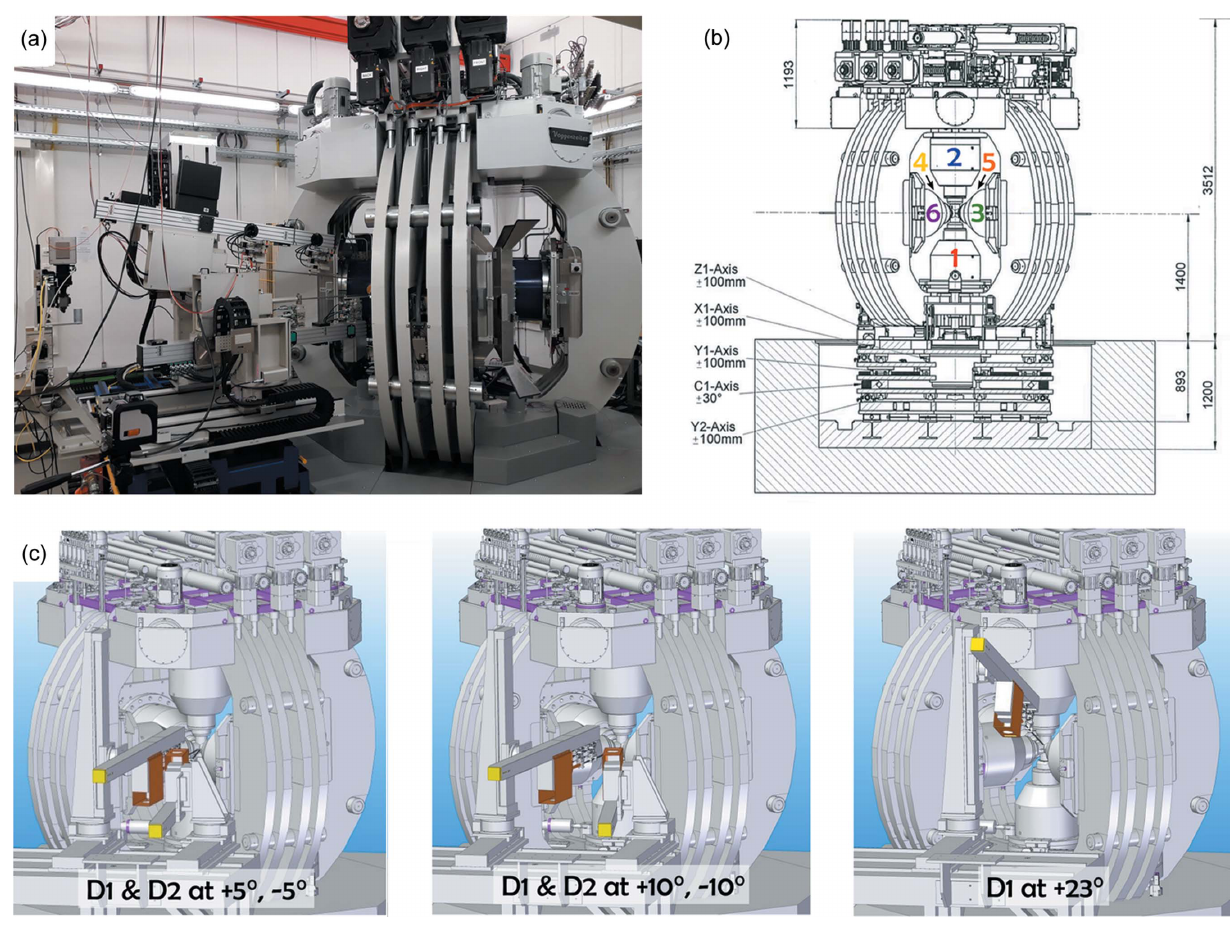
Figure 4 Instrumentation at P61B. ( a ) Photograph of the LVPAster-15, the detection positioning system with two Ge-SSDs and the X-ray microscope. Note that the plungers for the hydraulic rams are placed on top of the press frame. ( b ) Cross-section schematic of the LVP with the five-movement stages underneath (in a pit). Each stage is labeled accordingly for its movement direction, C1 indicates the rotation stage. ( c ) Various detector arrangements at their limit positions. Note, one Ge-SSD can be at (cid:7) 3 (cid:5) as long as the other Ge-SSD is at a position of (cid:7) 5 (cid:5) in both horizontal